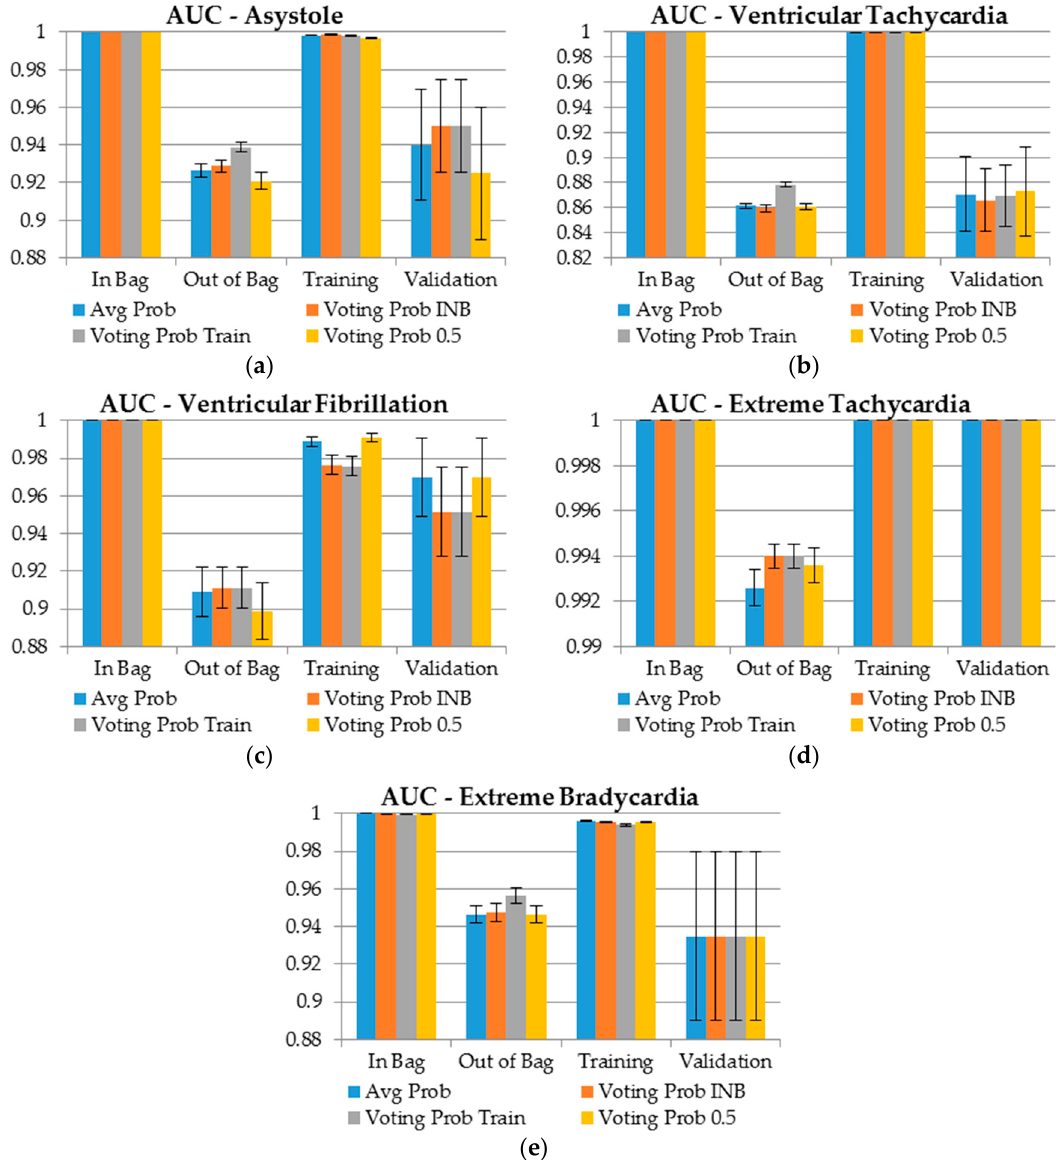
Figure 3. AUC results for each type of arrhythmia and data sample in terms of method of probability assignment . ( a ) Asystole, ( b ) Ventricular Tachycardia, ( c ) Ventricular Fibrillation, ( d ) Extreme Tachycardia, ( e ) Extreme Bradycardia.